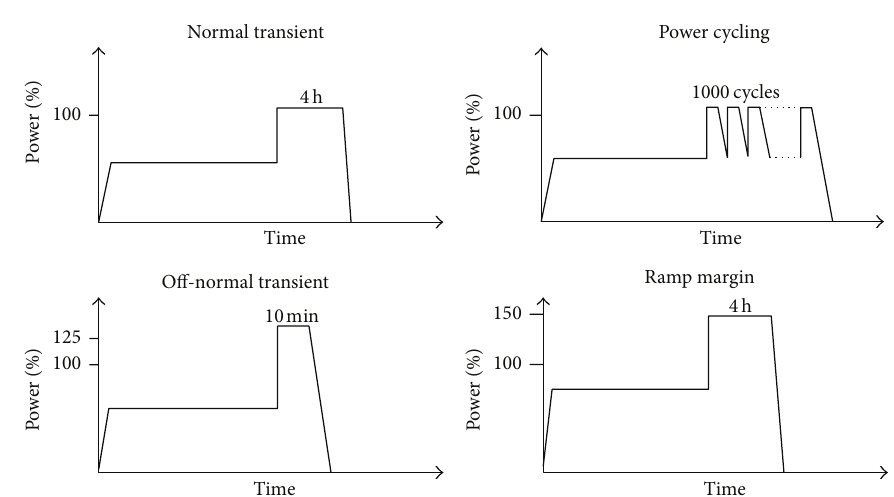
Figure 29: Four typical power ramp tests at Halden